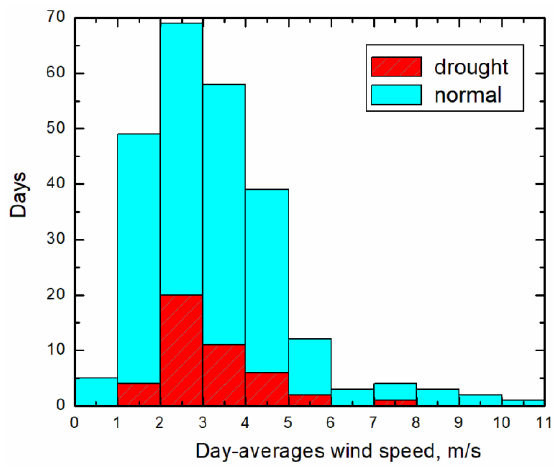
Figure 7. Distribution of days by wind speed.